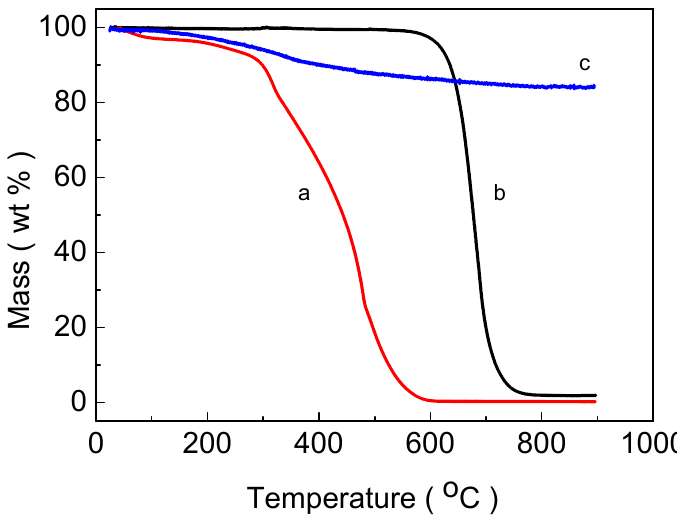
Figure 2. Thermogravimetric curves of hydrochar of glucose ( a ), core-shell C-SiC particles ( b ), hollow SiC particles ( c ) recorded in dry air.